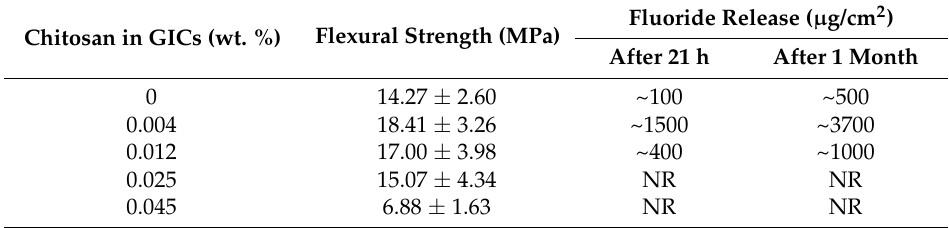
Table 2. Summary of the flexural strengths of different formulations of chitosan-modified glass ionomer restorations along with estimated fluoride release [156]. GICs: glass ionomer cements.